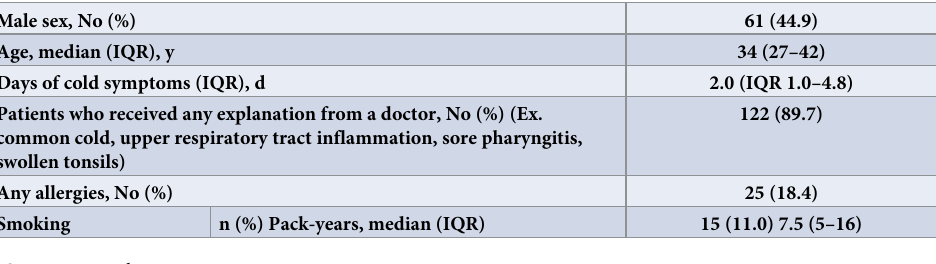
Table 1. Background characteristics of patients (n = 136).